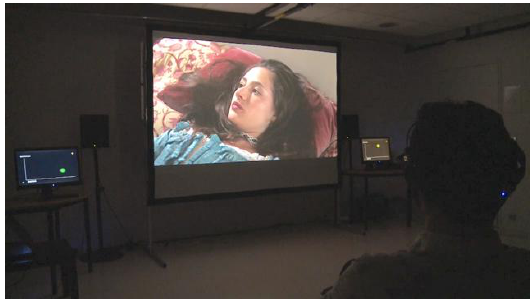
Figure 1. The ‘emotional cinema’ project, in which our work is used. The spectator is equipped with an Epoc EEG headset. A secondary screen give him a feedback of his own emotional state.